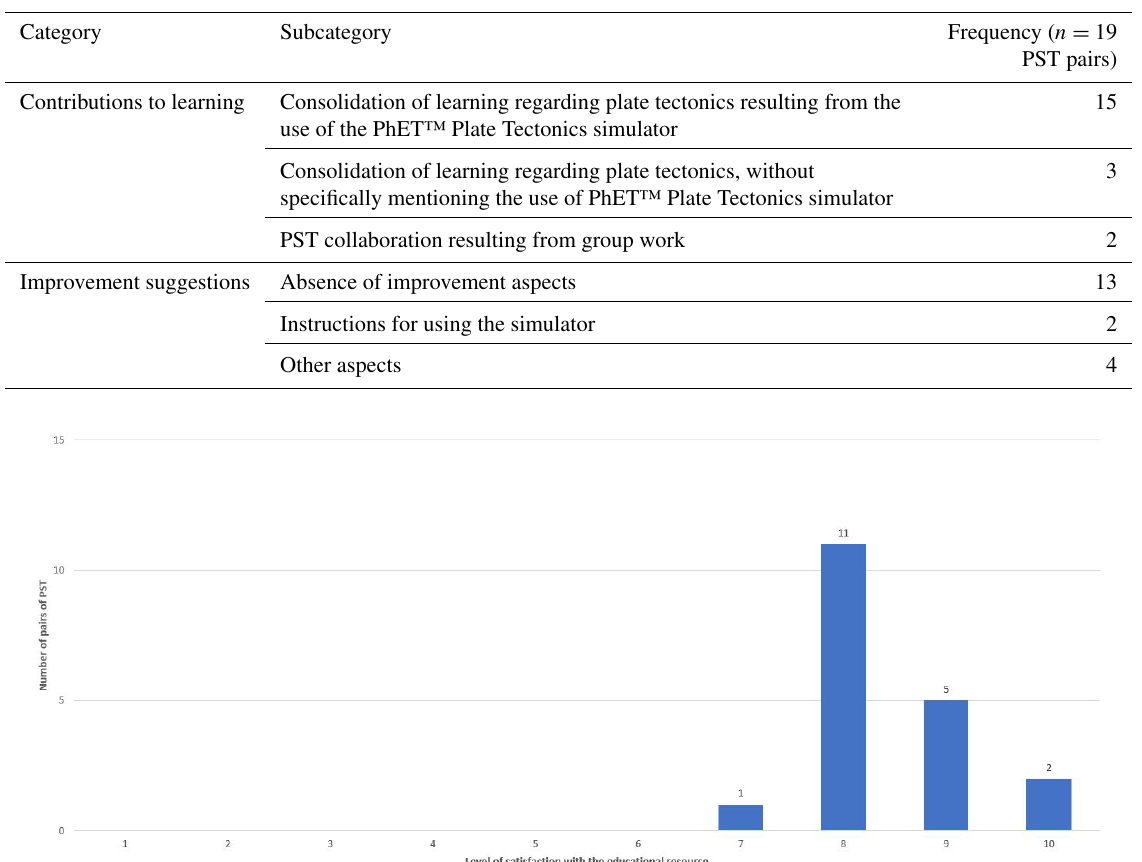
Figure 9. Chart showing evaluations from PSTs concerning the contribution of the educational resource CreativeLab_Sci&Math | Plate Tectonics to their